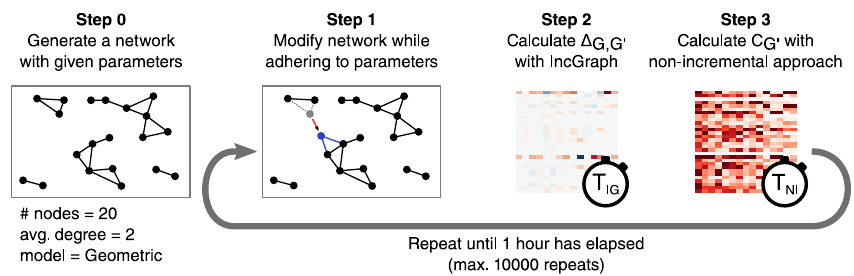
Fig 3. Static network model generators were modified to generate dynamic networks. Three network models were used: Baraba´si-Albert, Erdős-Re´nyi, and Geometric. Step 0: a network is generated according to the network model and the given parameters. Step 1: the network is modified such that the result is as likely to have been generated by the network model. Step 2: The time for IncGraph to calculate the differences in graphlet counts is measured ( T IG ). Step 3: The time for the non-incremental approach to calculate the graphlet counts of the new network is measured ( T Steps 1 to 3 are repeated until all modifications generated at step 0 are processed, or until an execution time threshold has been